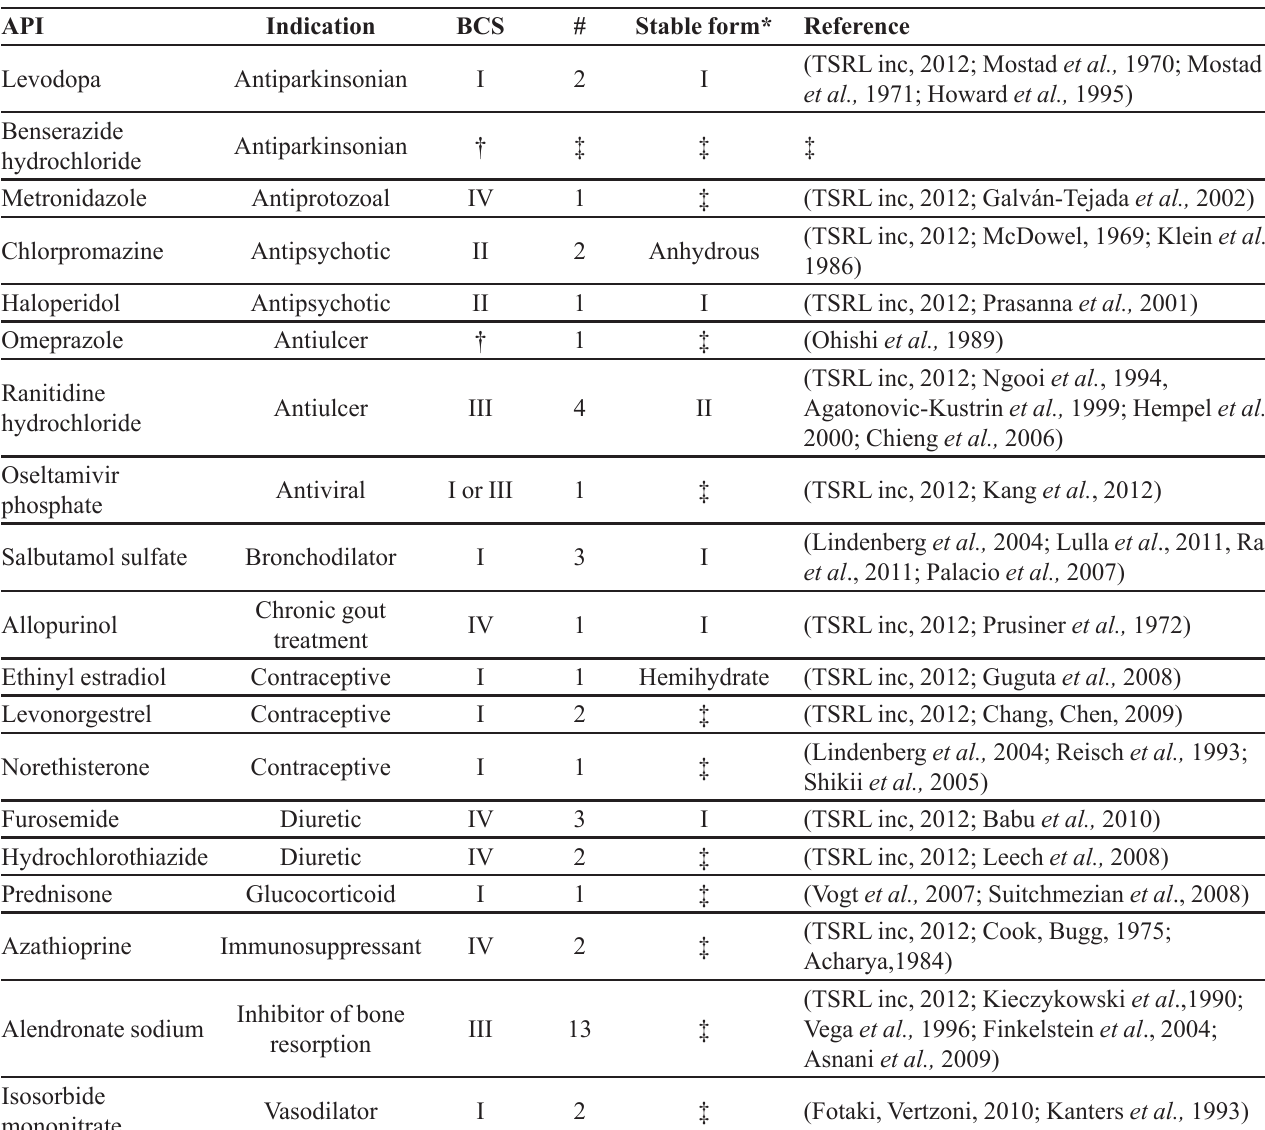
TABLE I - Solid-state forms of Farmácia Popular drugs